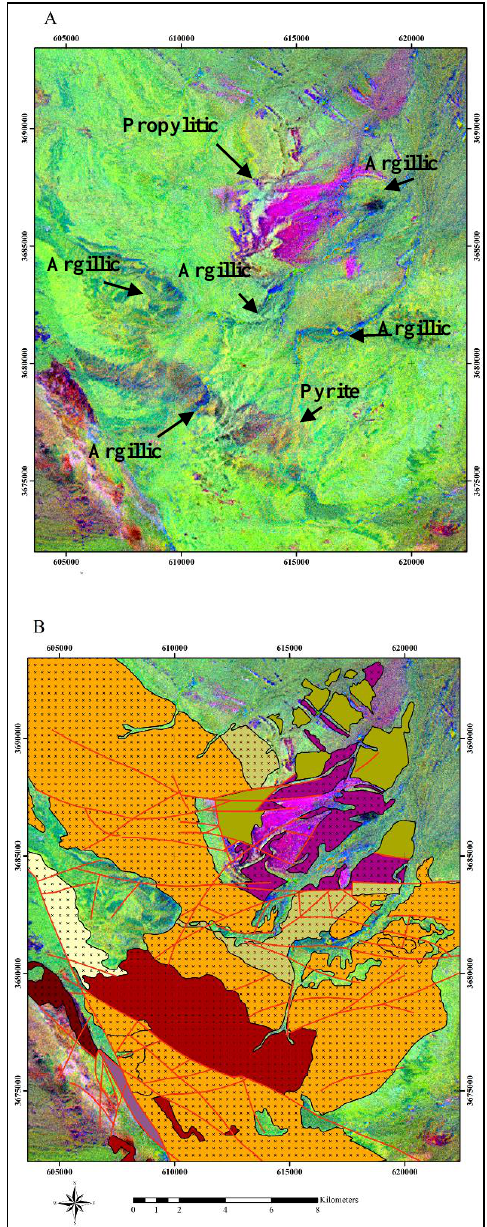
Figure 10. A) RGB color composite of IC2, IC3 and IC6 images. The identified pyrites are related to argillic and propylitic as major minerals in mineralogy zones for copper deposits. B) Argillic alteration is revealed in margin bedrock. The propylitic alterations are surrounded by meta monzodiorite in sedimentary bedrock. There are faults in this area, causing lava to appear at the surface. The pyrite in diorite-monzodiorite intrusive rock is surrounded by argillic alteration, so copper is likely to increase in this position.